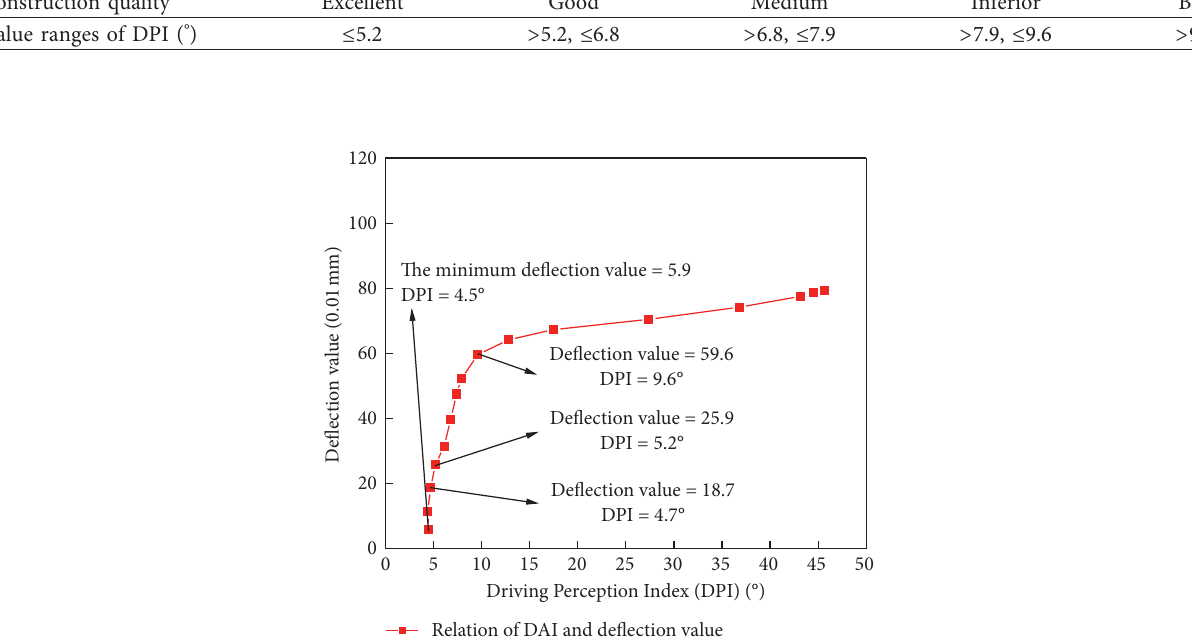
Figure 14: The relationship between IRI and DPI. Table 11: Evaluation standard of construction quality for asphalt pavement based on DPI. Construction quality